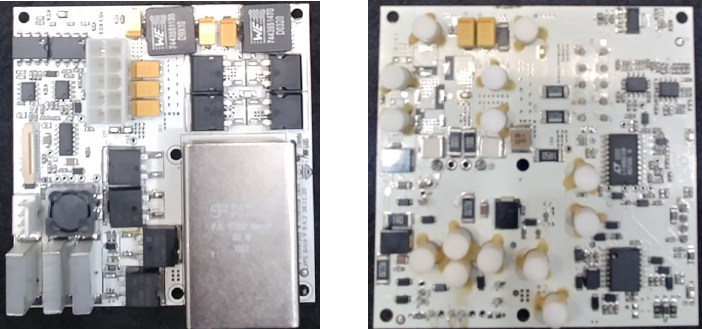
Figure 2. A top-view image of a V8.4.2 LVPS Brick prototype ( Left ). A bottom view image of a V8.4.2 LVPS Brick ( Right ).